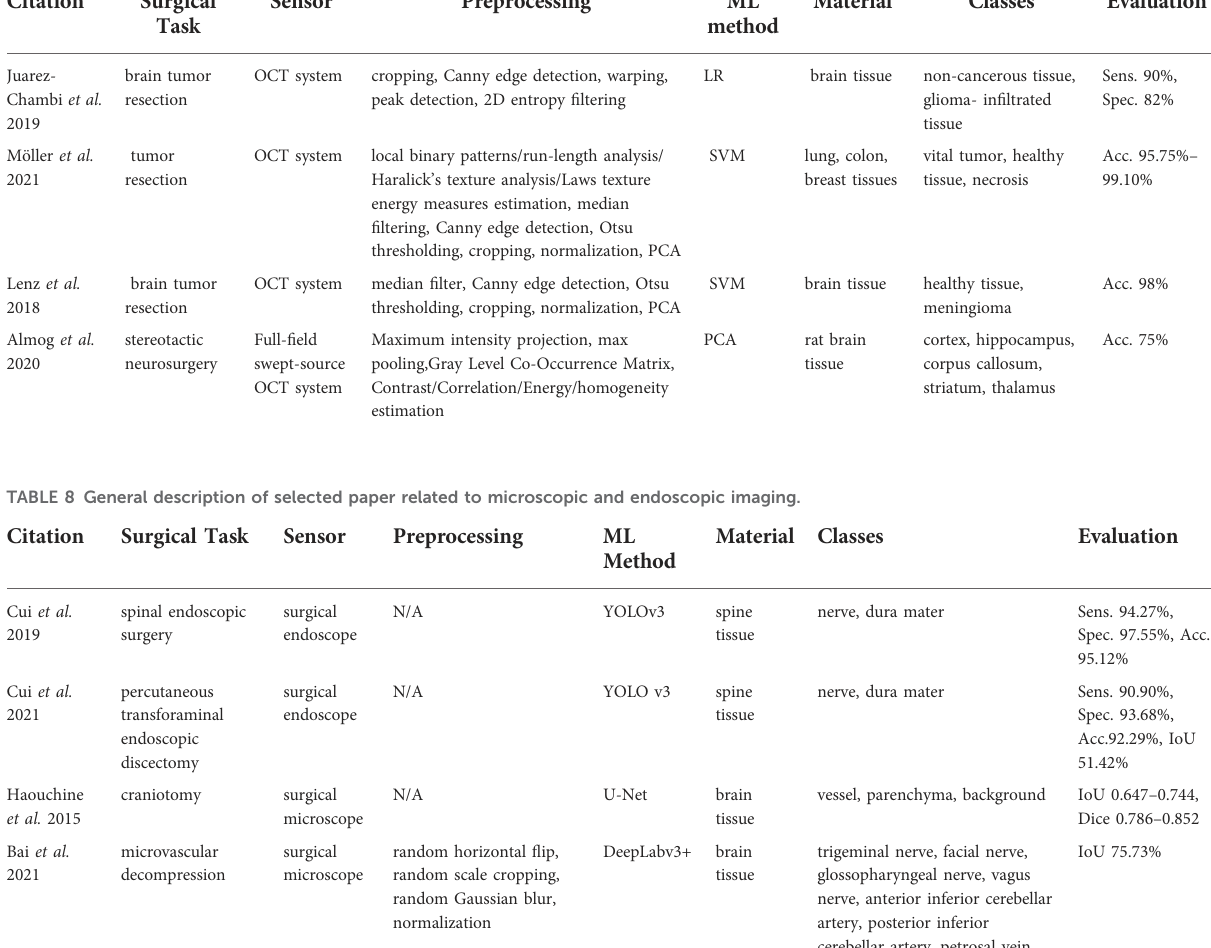
Haouchine et al.